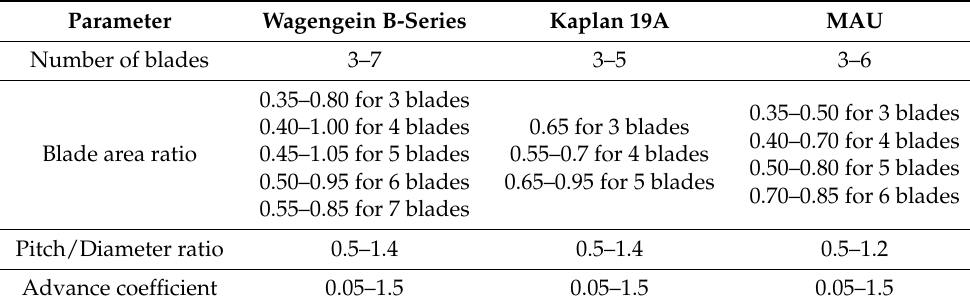
Figure 4. General plan of MAU series [14]. Table 3. Parameters of propeller